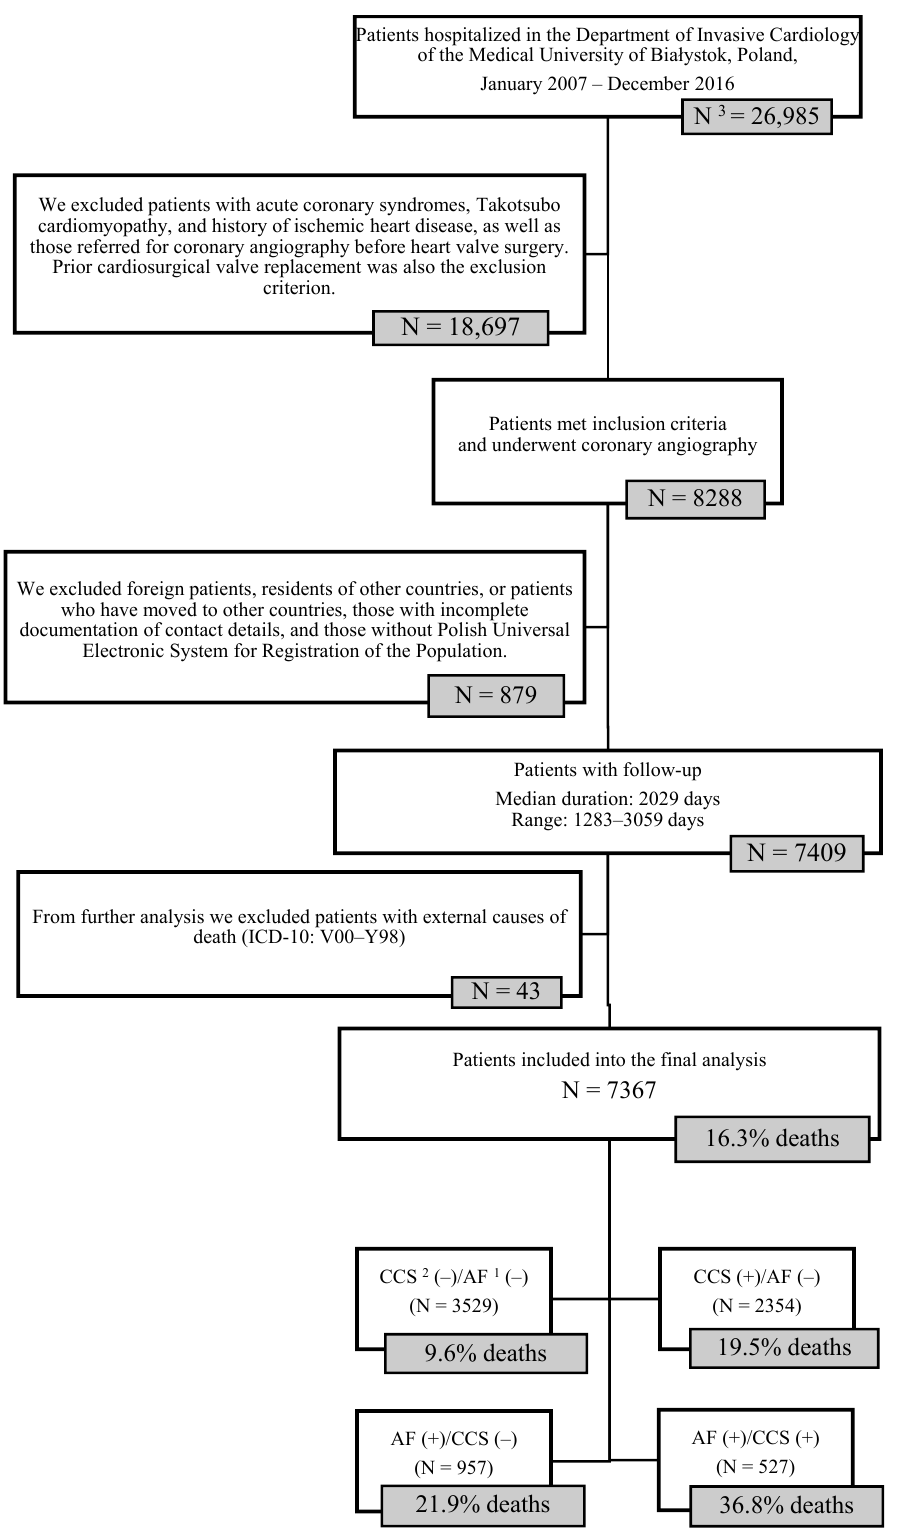
Figure 1. Selection of the study population. 1 AF, atrial fibrillation; 2 CCS, chronic coronary syndrome; 3 N, number